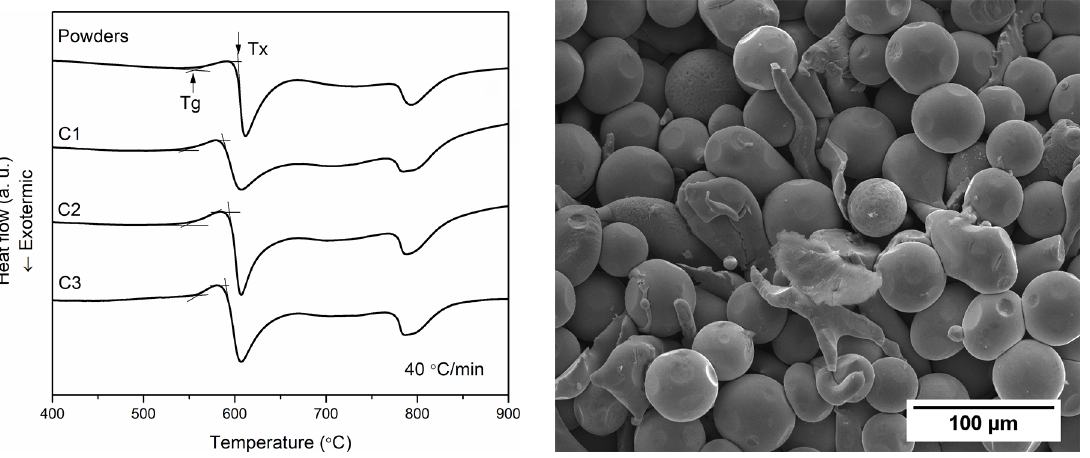
Figure 2. DSC curves of the GAP and the consolidated samples. Figure 3. SEM-SE micrograph showing the surface of the C1 Table 1. The transformation temperatures Tg, Tx and ΔTx (= Tx – Tg), measured density and mean hardness value of the GAP and consolidated samples.